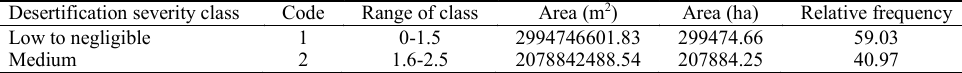
Table 11: Weighted average of desertification severity